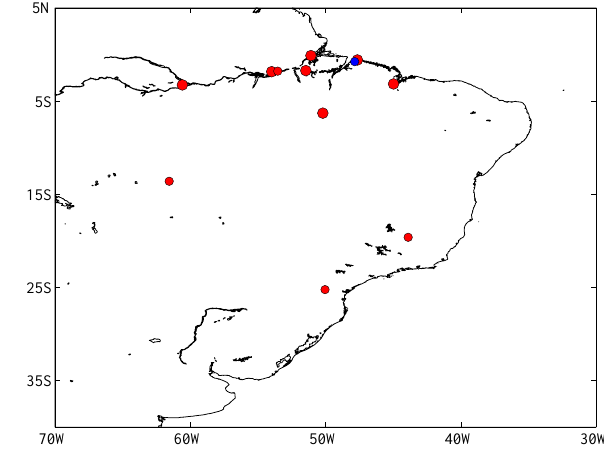
Fig. 4. MH precipitation/moisture palaeodata in eastern South America. Symbol colours: blue circles, wetter than modern; red cir- cles, drier than modern; grey circles, similar to modern; red stars, dry-to-wet transition; and blue stars, wet-to-dry transition. Sym- bol size refers to palaeodata Q -index (a chronological reliability index; see text for more information) values; larger symbols indi- cate higher Q -index values. Vertical axis refers to latitude values, and horizontal axis refers to longitude values.